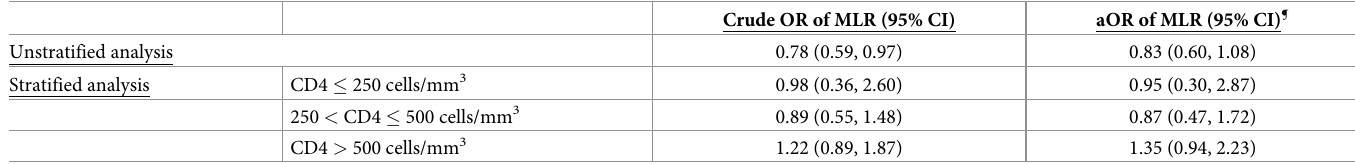
Table 2. Bivariate (crude OR) and multivariate logistic regression analysis (adjusted OR) of the relationship between MLR (per 0.1 unit increase) and qualitative TST results (negative vs positive result), overall and stratified by CD4 count category.